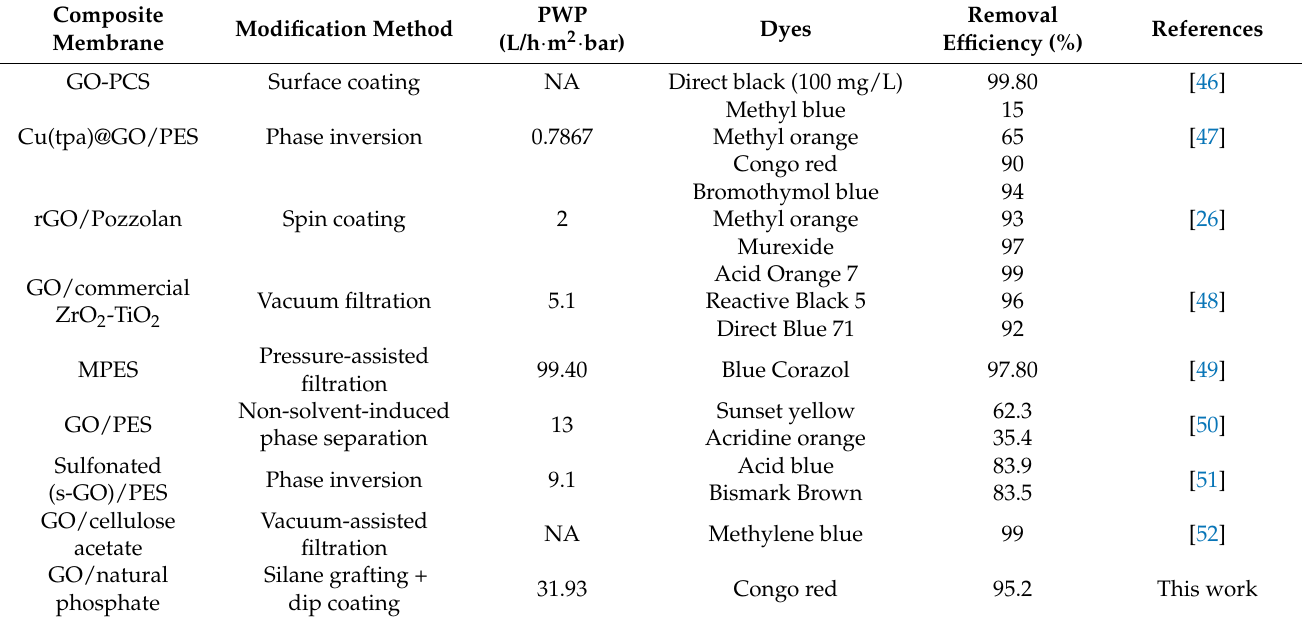
Table 1. Overview of recent publications on GO/composite membranes for dye